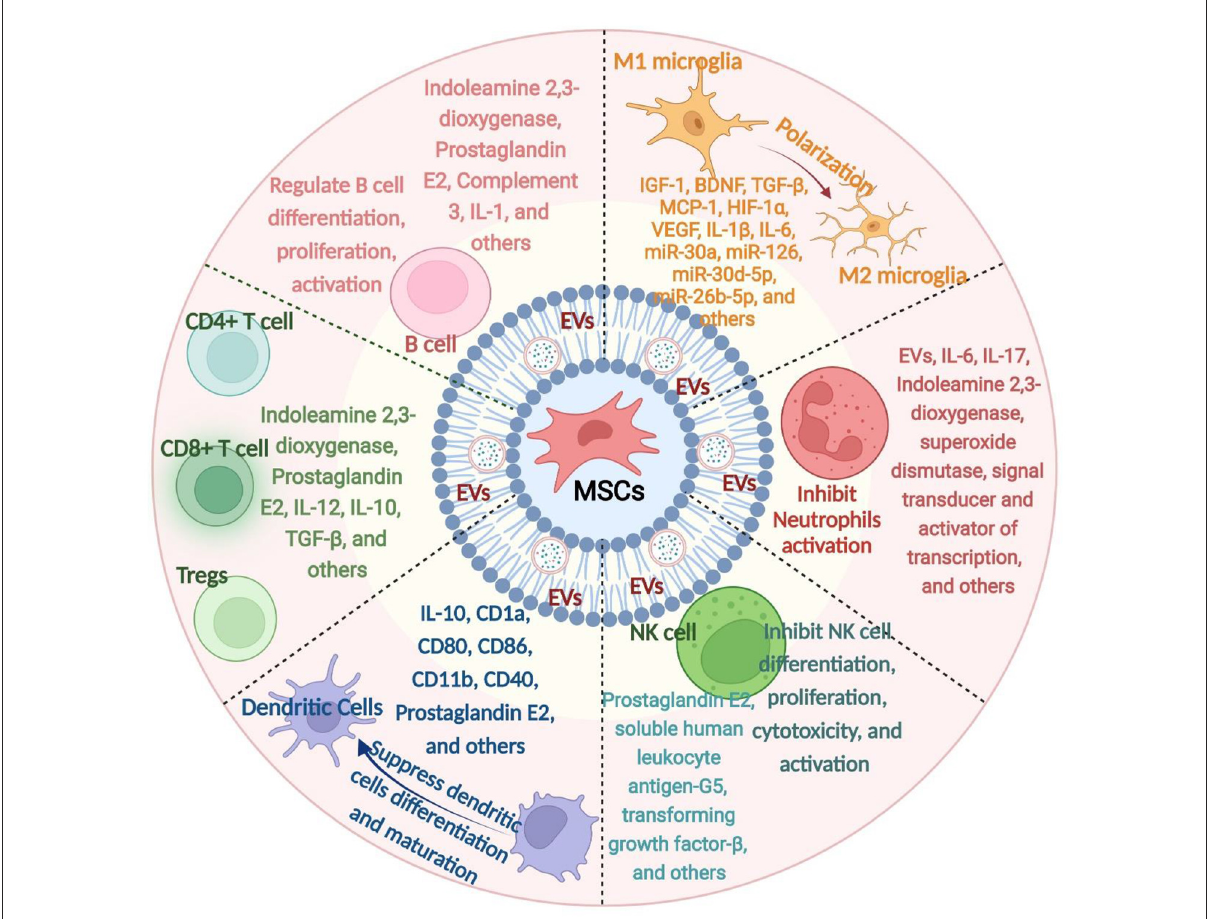
FIGURE1 An overview of how mesenchymal stem cells (MSCs) interact with immune cells. MSCs derived from various tissue sources can release a series of mediators, which in turn interact with various immune cells, namely microglia, neutrophils, natural killer cells, dendritic cells, T cells, and B cells. IL, interleukin; EVs, extracellular vesicles; MSCs, mesenchymal stem cells; NK cell, Natural Killer cell; IGF-1, insulin-like growth factor 1; VEGF, vascular endothelial growth factor; bFGF, fibroblast growth factor; MCP-1, Monocyte chemoattractant protein-1; miR, microRNA; TGF- β , transforming growth factor- β